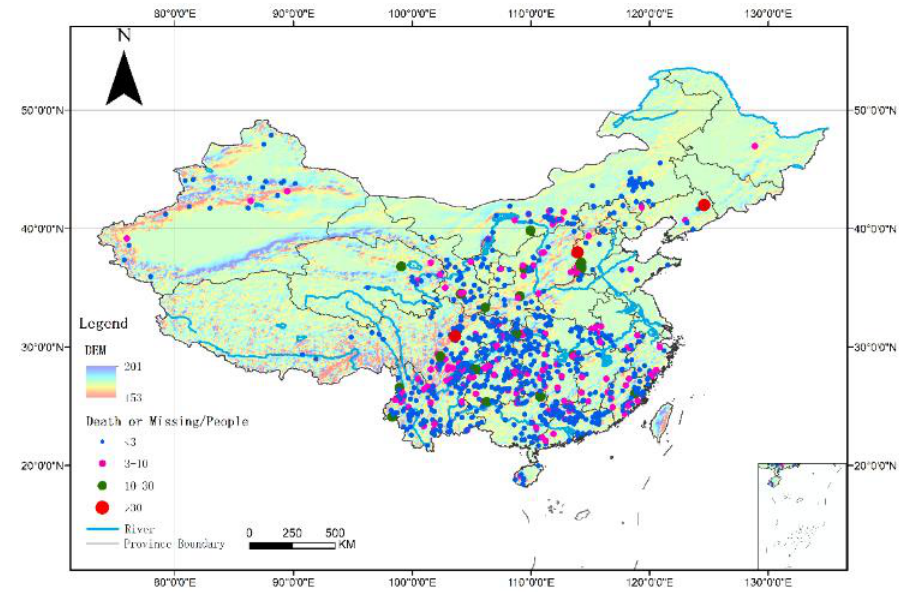
Figure 1. Locations and fatalities of flash floods across China in 2011 – 2016.